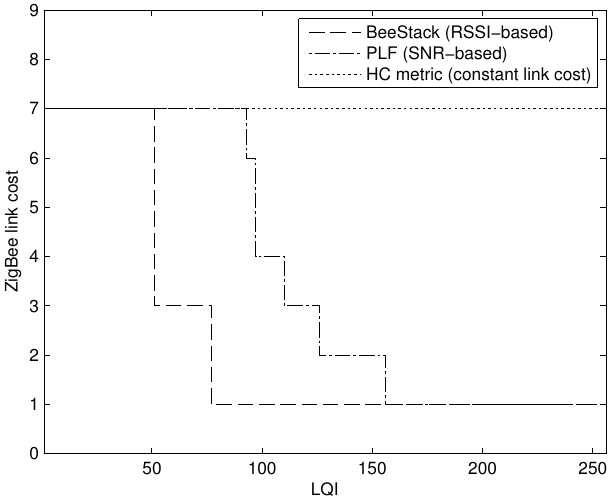
Figure 2. Mapping of link quality indication (LQI) to link cost values by the BeeStack [30], hop count (HC) and piecewise linear function (PLF) [31] routing